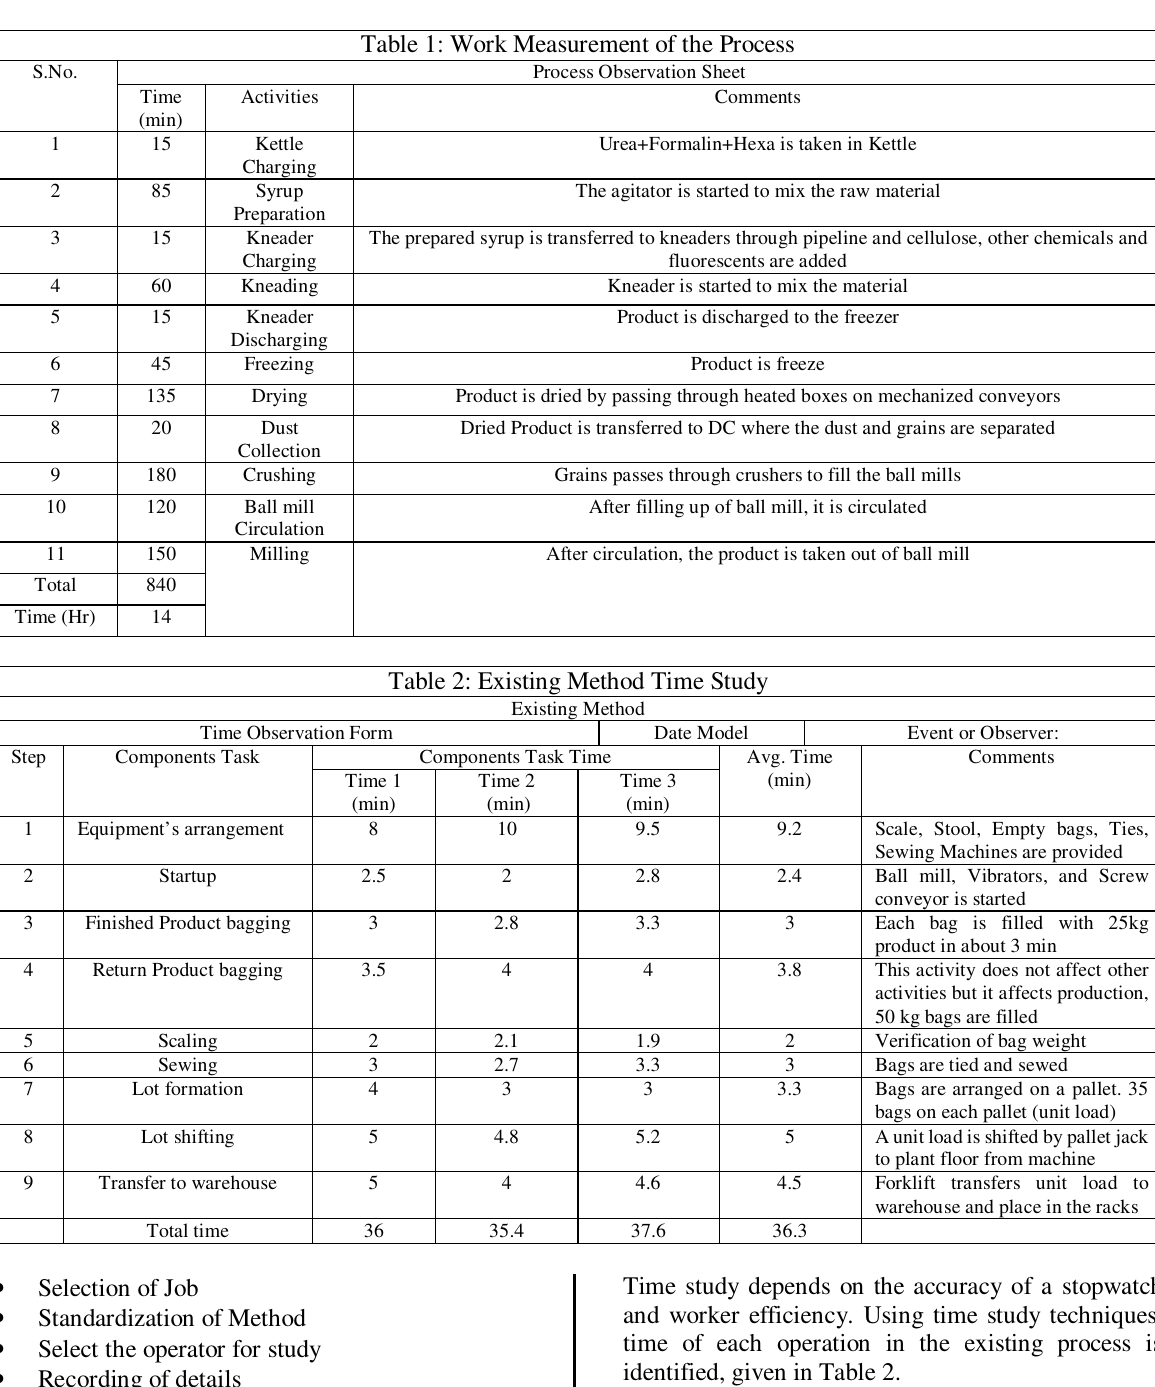
Table 1: Work Measurement of the Process